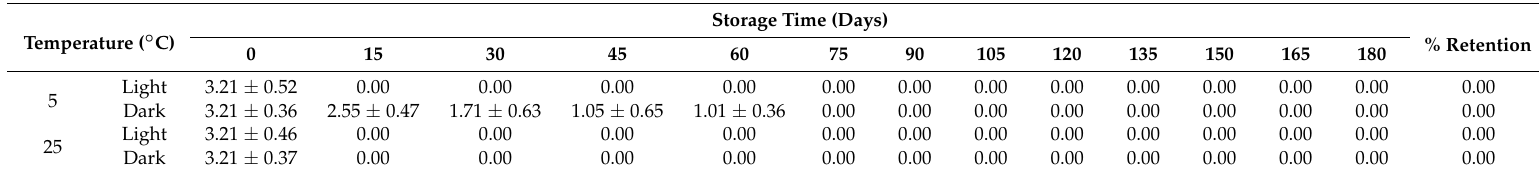
Table 6. Stability profile of 4-allyl-1,2-diacetoxybenzene under different storage temperatures and light for 180